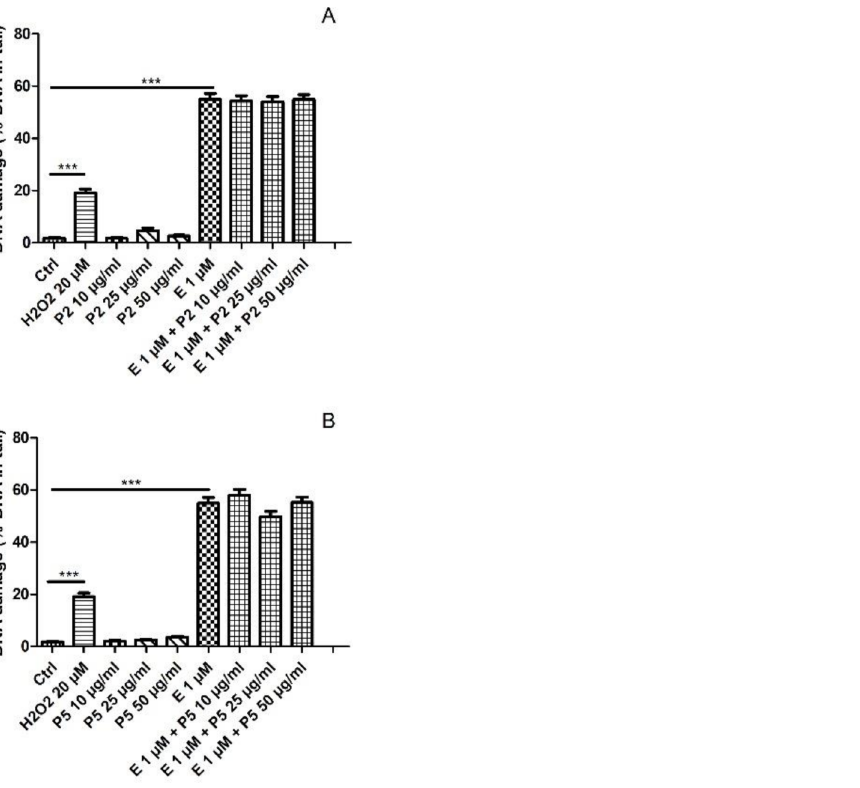
Figure 4. DNA damage, measured as the comet tail DNA (%) of HL-60 cells incubated for 2 h at 37 ◦ C with P2 ( A ) and P5 ( B ) derivative (10–50 µ g/mL) and 1 µ M etoposide (E), analyzed by the alkaline comet assay. The figure shows mean results ± standard error of the mean (SEM), n = 100; *** p < 0.001.